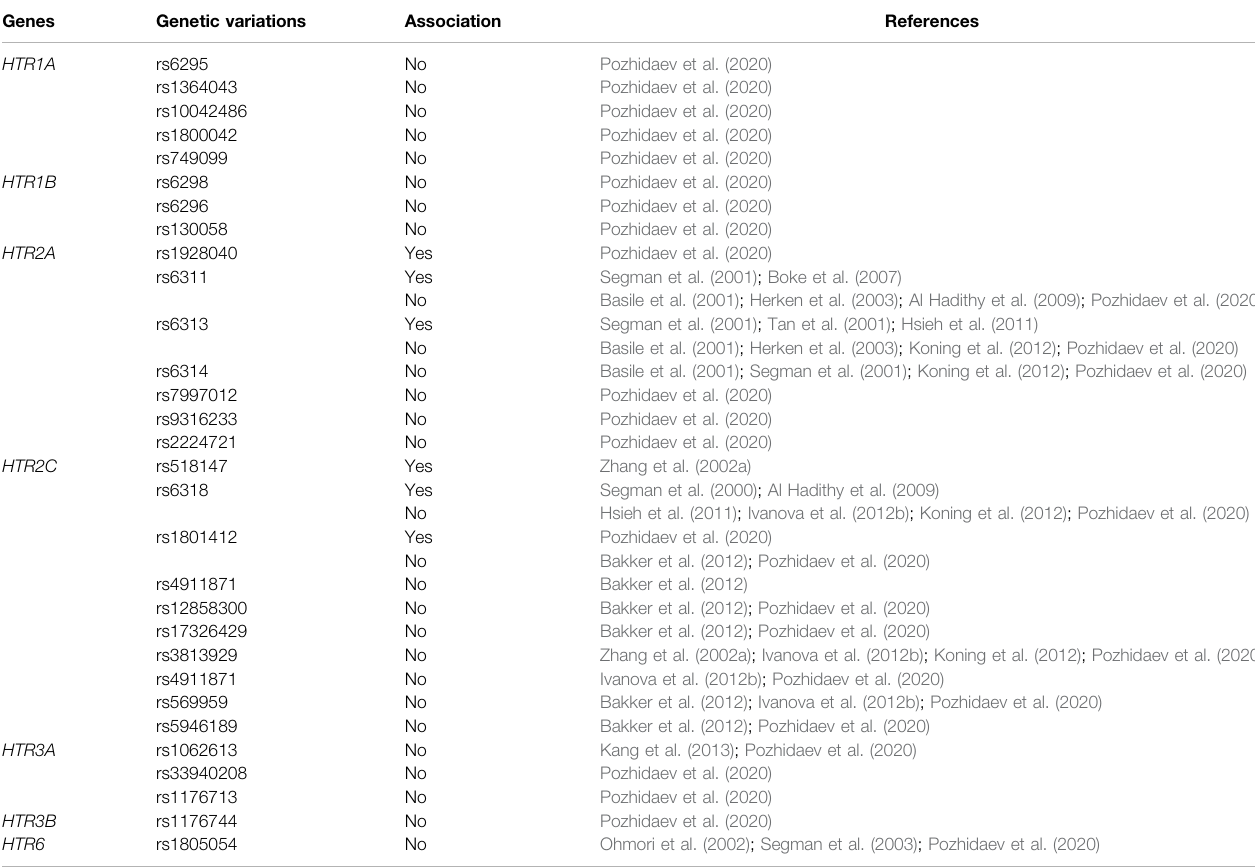
TABLE 3 | Genetic variability of serotonin receptors and its association with